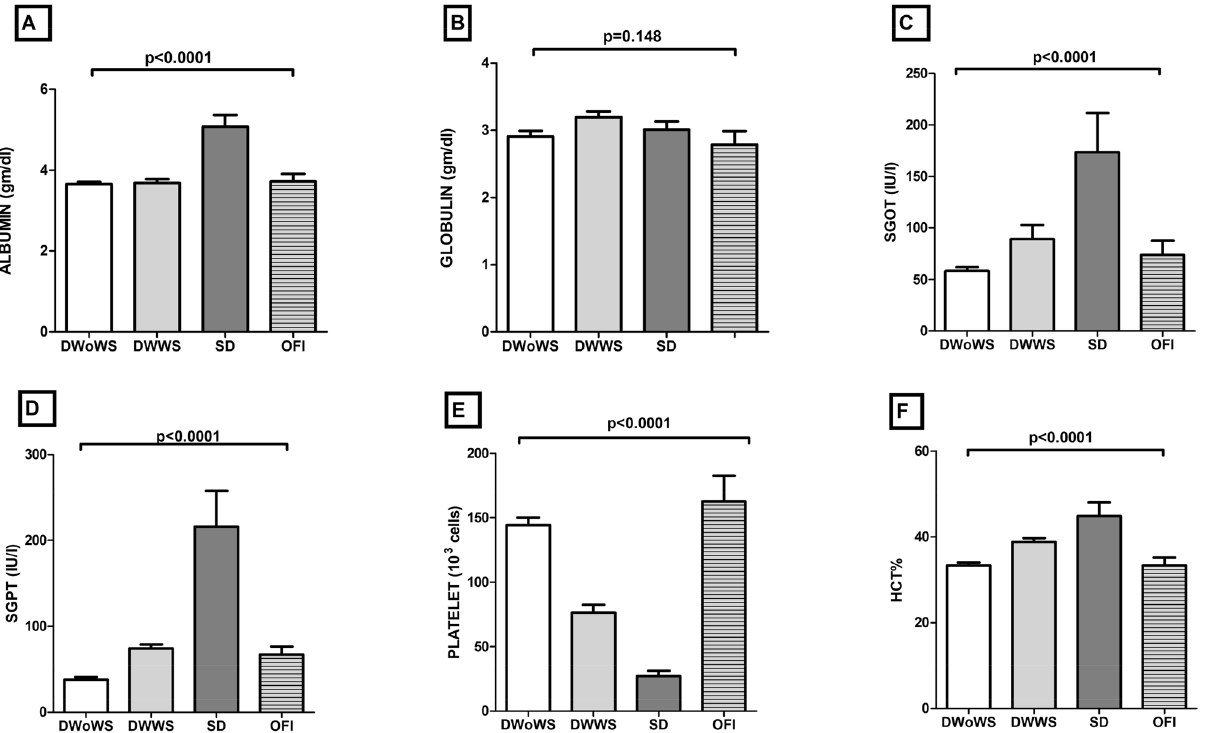
Figure 1. Level of serum ( A ) Albumin, ( B ) Globulin, ( C ) SGOT, ( D ) SGPT, ( E ) Platelet and ( F ) HCT of Dengue Without Warning Signs (DWoWS), Dengue With Warning Signs (DWWS), Severe Dengue (SD) versus Other febrile infection (OFI). Study subjects are significantly different from each category is indicated by P < 0.05. Statistical analysis was performed using the Graph-Pad Prism statistics software (Graph-Pad Software Inc., San Diego, CA, USA free demo version